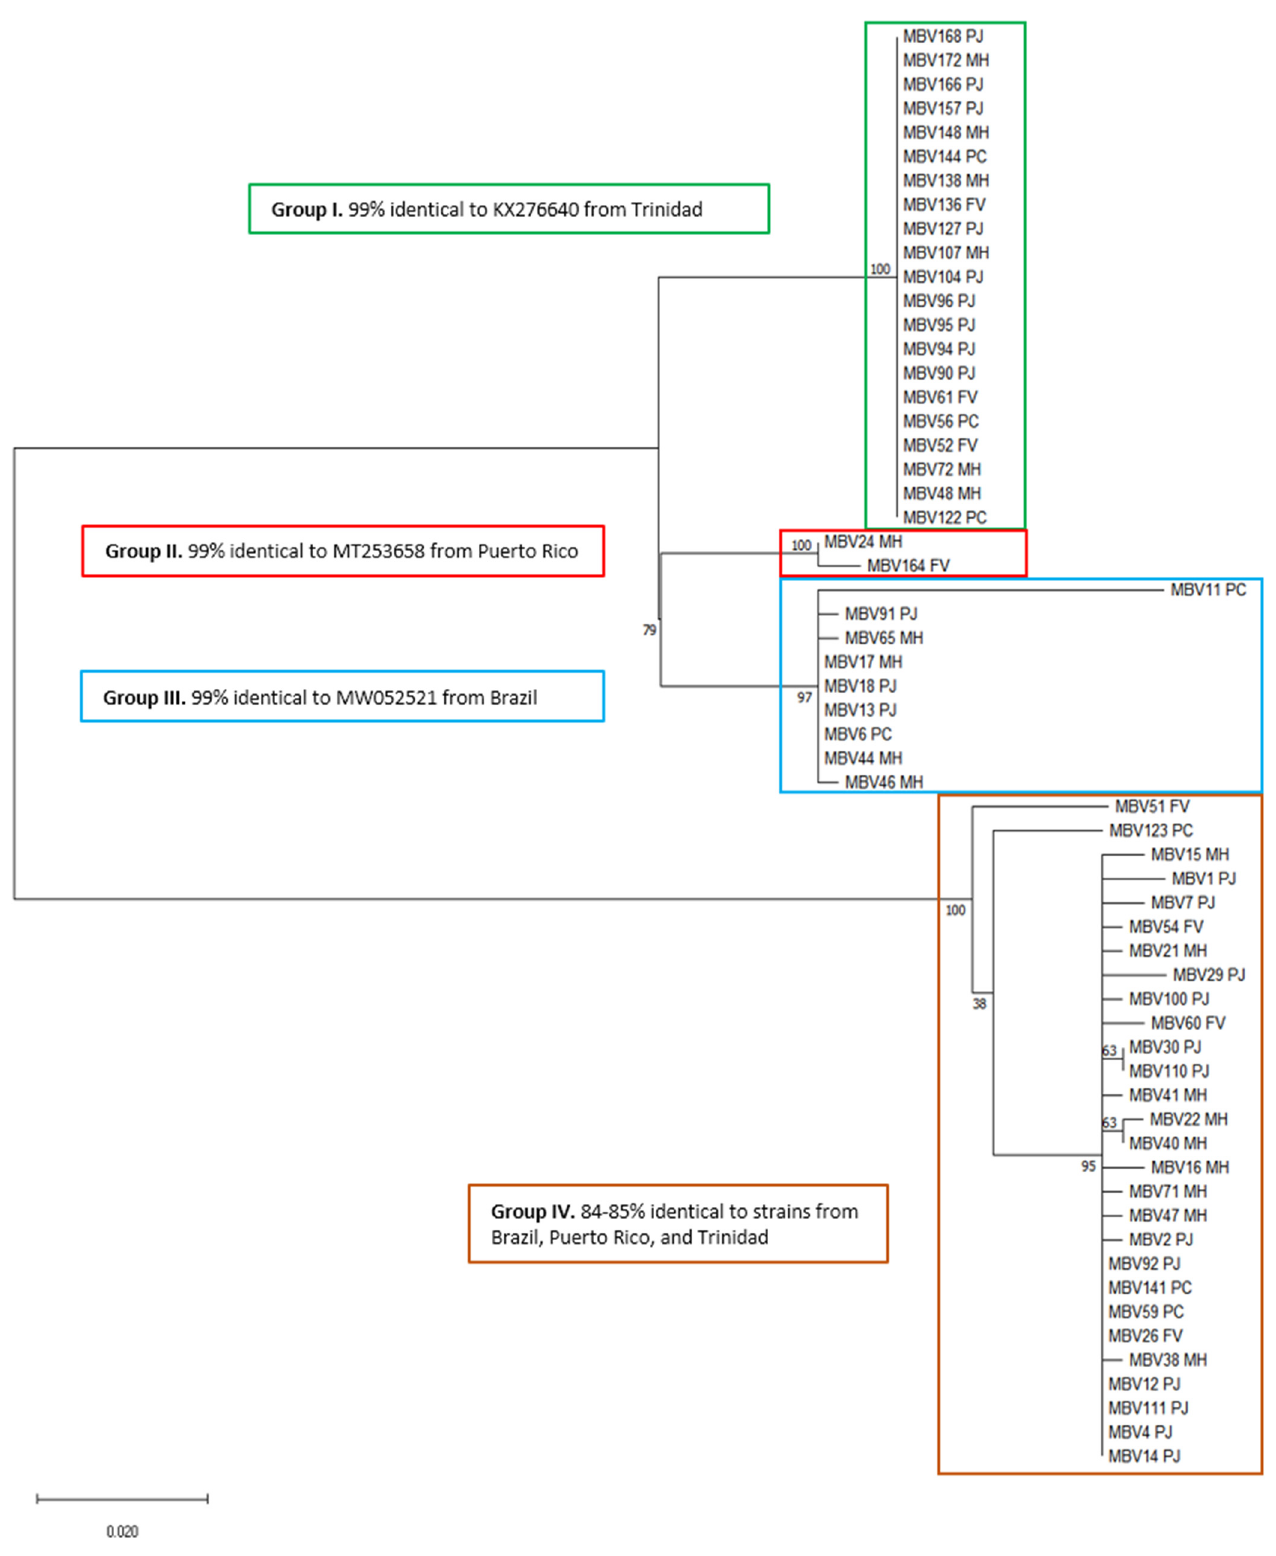
Figure 4. Phylogenetic tree constructed using the nucleotide sequences of the coat protein region of cacao mild mosaic virus . Sequence names are followed by the initials of the mealybug species in which they were found; P. jackbeardsleyi (PJ), P. comstocki (PC), M. hirsutus (MH), and F. virgata (FV).